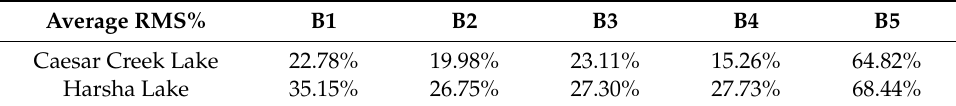
Table 3. Average RMS% of the GEE Landsat 8 reflectance data in comparison with ASD